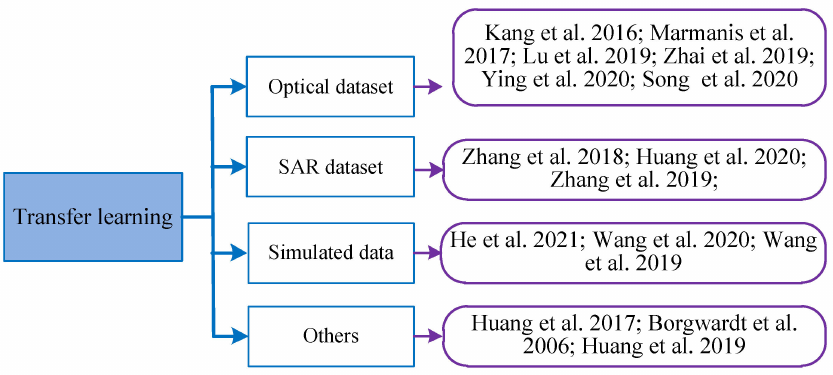
Figure 15. Transfer learning used in SAR ATR